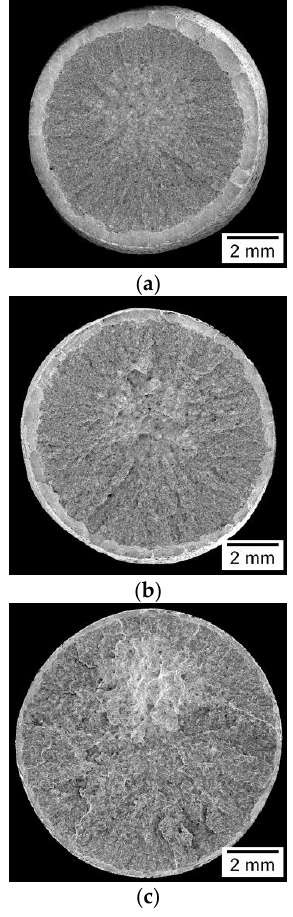
Figure 4. Top view of the fracture surfaces in the steels cooled using: ( a ) AC; ( b ) POF; ( c ) FCF.